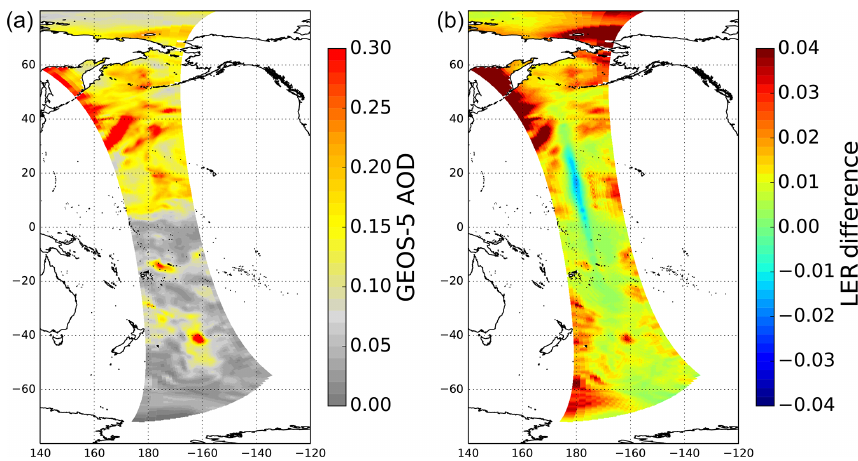
Figure 5. Map showing the results from GLER aerosol simulation on 10 April 2006 for orbit 9229. Panel (a) is GEOS-5 470nm AOD used in the simulation and panel (b) is change in GLER when the aerosol contribution is added to the simulations at 466nm.